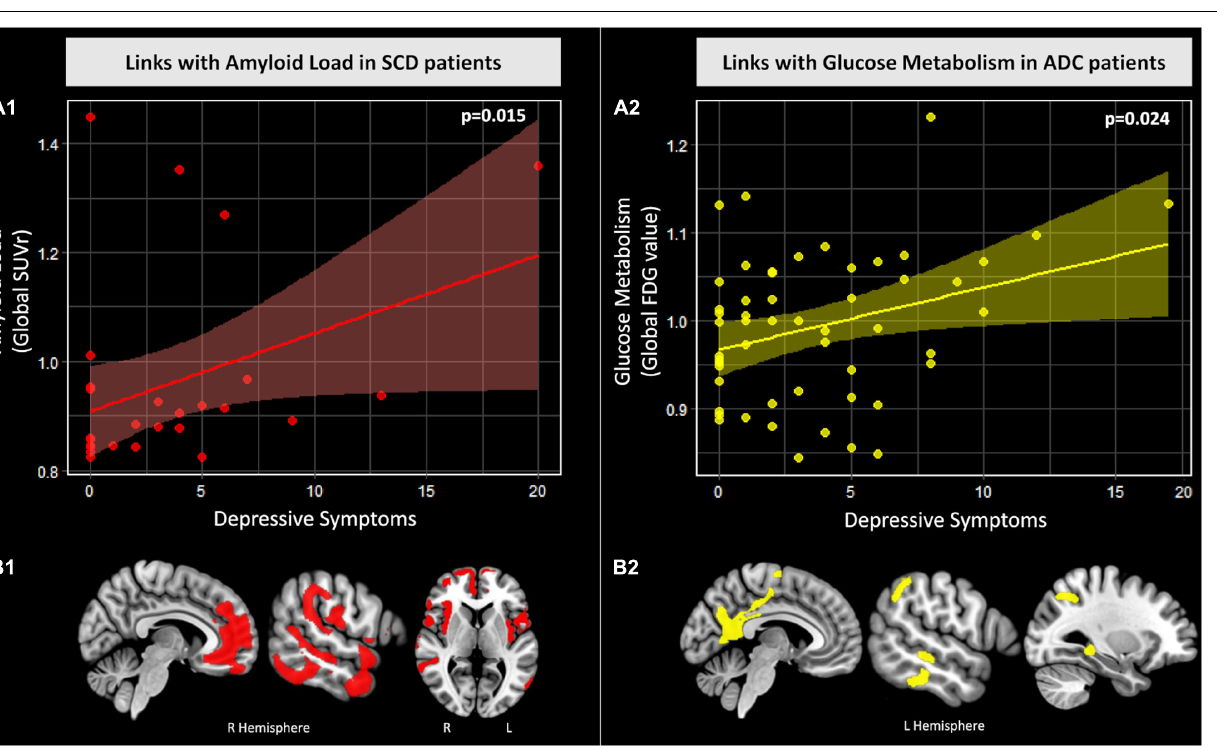
Frontiers in Aging Neuroscience |